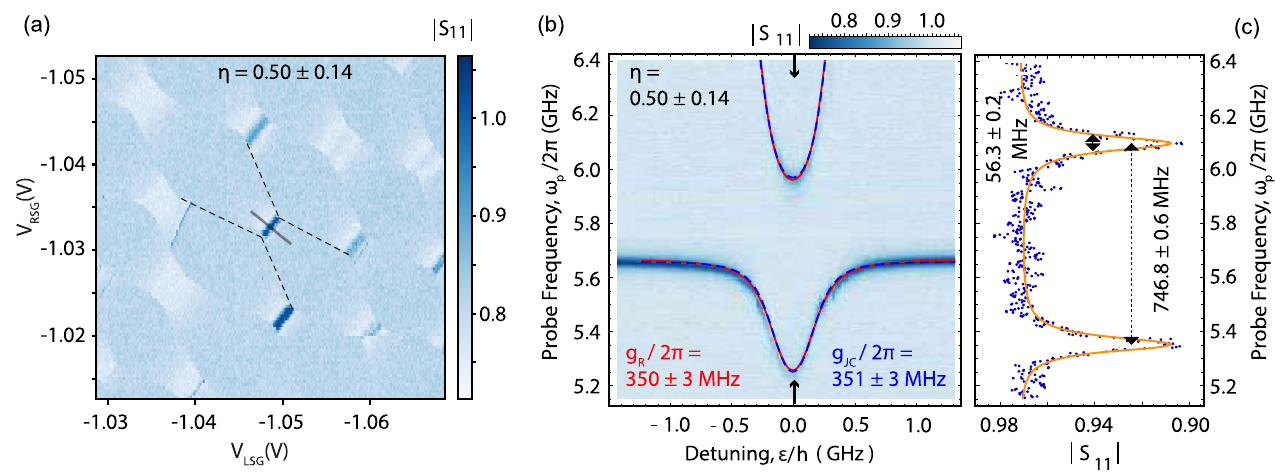
FIG. 11. Investigation of a configuration approaching the ultrastrong-coupling regime for a DQD with η ∼ 0 . 50 (cid:3) 0 . 14 coupled to a JJ array. (a) Charge stability diagram of the DQD measured by monitoring the change in resonator reflectance amplitude j S 11 j for the extracted dipole strength η ∼ 0 . 50 (cid:3) 0 . 14 . (b) Resonator amplitude response j S 11 j taken by varying the DQD detuning ϵ along the gray line indicated in (a) by applying properly chosen voltages to the two side gates. The red (blue) lines are independent fits to the Rabi (JC) = 2 π Þ taken along the black arrows in (b). The orange line represents a fit to a model (see Appendix F). (c) Line cut representing j S 11 jð ω p = 2 π ¼ 19 . 5 MHz and κ = 2 π ¼ 4 . 3 (cid:3) 0 . 1 JC master equation model. The resonator losses are κ int ext